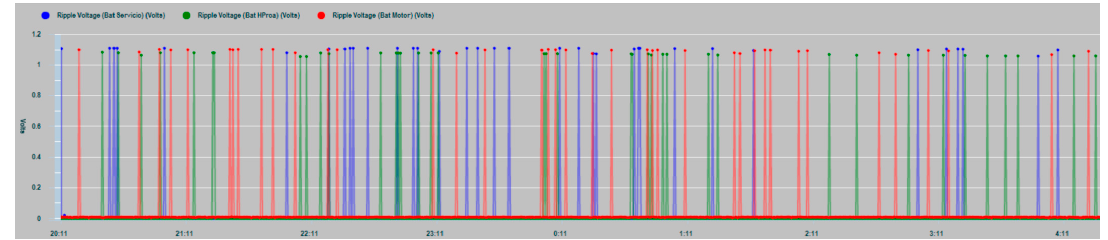
Figure 23. Ripple voltage data-series measurements on the three battery banks: House battery banks (dark blue), bow thruster battery banks (green), and engine battery banks (red).